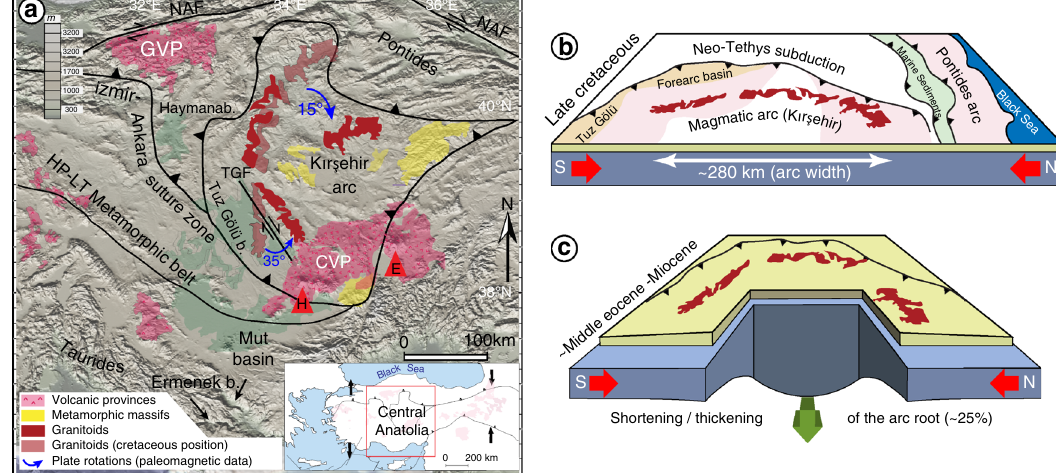
Fig. 1 Geological setting and lithospheric evolution of Central Anatolia. a Generalized map of Central Anatolia showing continental blocks and their major tectonic boundaries. Simpli fi ed surface geological elements are shown to illustrate geologically inferred connection with the deep lithospheric removal process. CVP Cappadocia Volcanic Province, GVP Galatian Volcanic Province, TGB Tuz Gölü Basin, TGF Tuz Gölü Fault, NAF North Anatolian Fault, E Erciyes volcano, H Hasanda ğ volcano, Green area shows basins. b Schematic illustration of restored tectonic con fi guration and geologic features during the late Cretaceous 29 showing intact lithosphere. c Schematic showing folding of the Central Anatolian (K ı r ş ehir) arc about a vertical axis and ~25% shortening 31 culminating in the Middle Eocene – Miocene 32,33 . Such folding yields local thickening of the arc root and the onset of